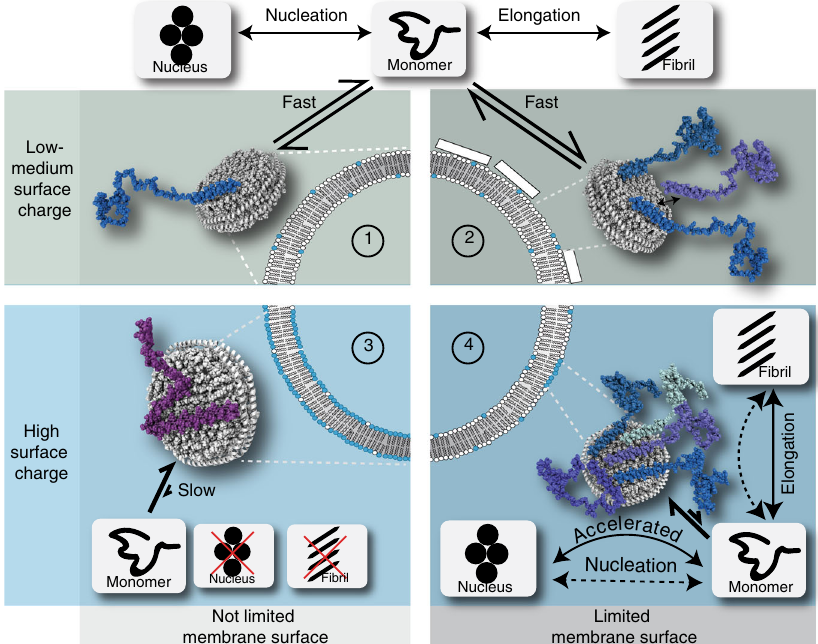
Fig. 6 Model of the in fl uence of different NDs on the α S aggregation pathways and speculations regarding their potential implication in the context of cell/ vesicle membranes. Four scenarios are depicted summarizing our in vitro data in respect to membrane surface charge and accessibility. (Note that schemes with nanodiscs and aggregation pathways are based on our fi ndings, while possible implications in respect to physiological membranes are purely speculative.) In cases where membranes/NDs with only low charge densities are present (scenario 1 and 2) α S interacts with its N-terminal residues and forms an exchanging equilibrium between soluble and membrane associated α S monomers (binding mode III in Fig. 5e). This equilibrium does not seem to strongly interfere with the slow process of α S nucleation, it may however (slightly) decrease the pool of free monomers available for fi bril formation. Although physiological membranes, in general, have a lower average charge density (represented by the upper panels), speci fi c, abnormal, and/or stochastic processes may also lead to highly charged lipid clusters (lower panels). In the unlikely case of not limiting surface access (scenario 3) α S will interact in a binding mode that will largely inhibit both α S nucleation and fi bril elongation (binding mode II in Fig. 5i). In cases with only local charge clusters, several α S monomers may compete for the limited highly charged membrane surface area (scenario 4). This binding mode (Fig. 5e mode I) can bring exposed NAC regions of several α S monomers in close proximity and accelerate the amyloid fi bril nucleation